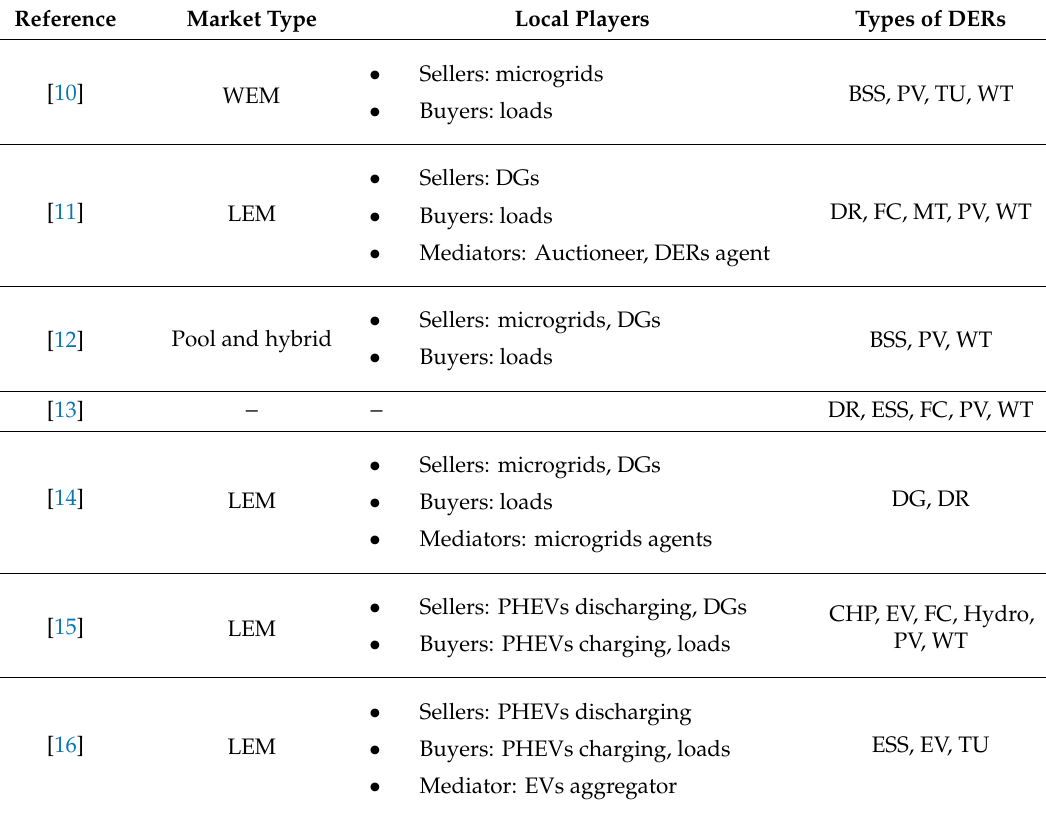
Table 1. Taxonomy of the reviewed energy